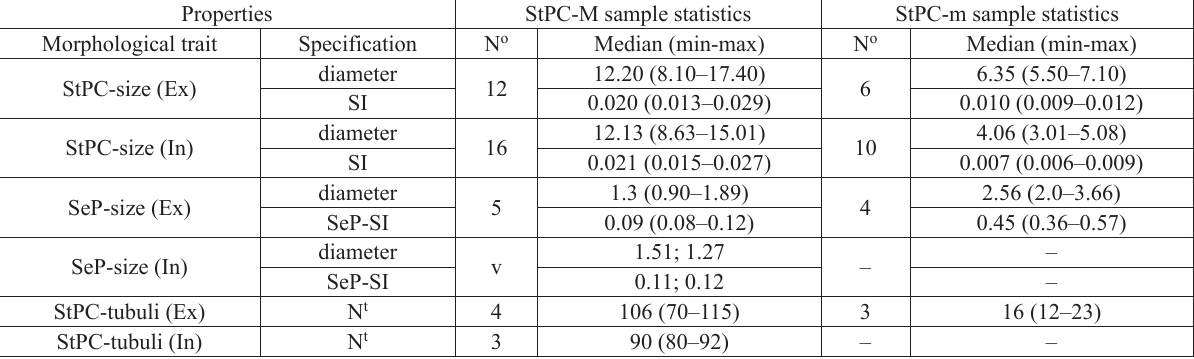
Table 3. Characterization of sieve-type normal pore canals (StPC) of Minyocythere maculosa (Bate, 1963), data only from German material. Abbreviations: StPC-m, small sieve-type normal pore canals with a large subcentral setal pore and reduced sieve plate; StPC-M, large round or